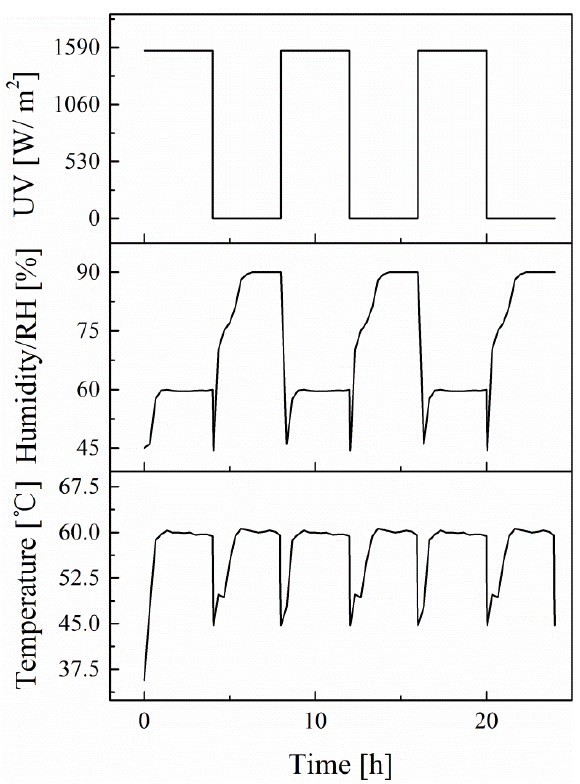
Figure 2. The time-course curves for UV light, humidity, and temperature.